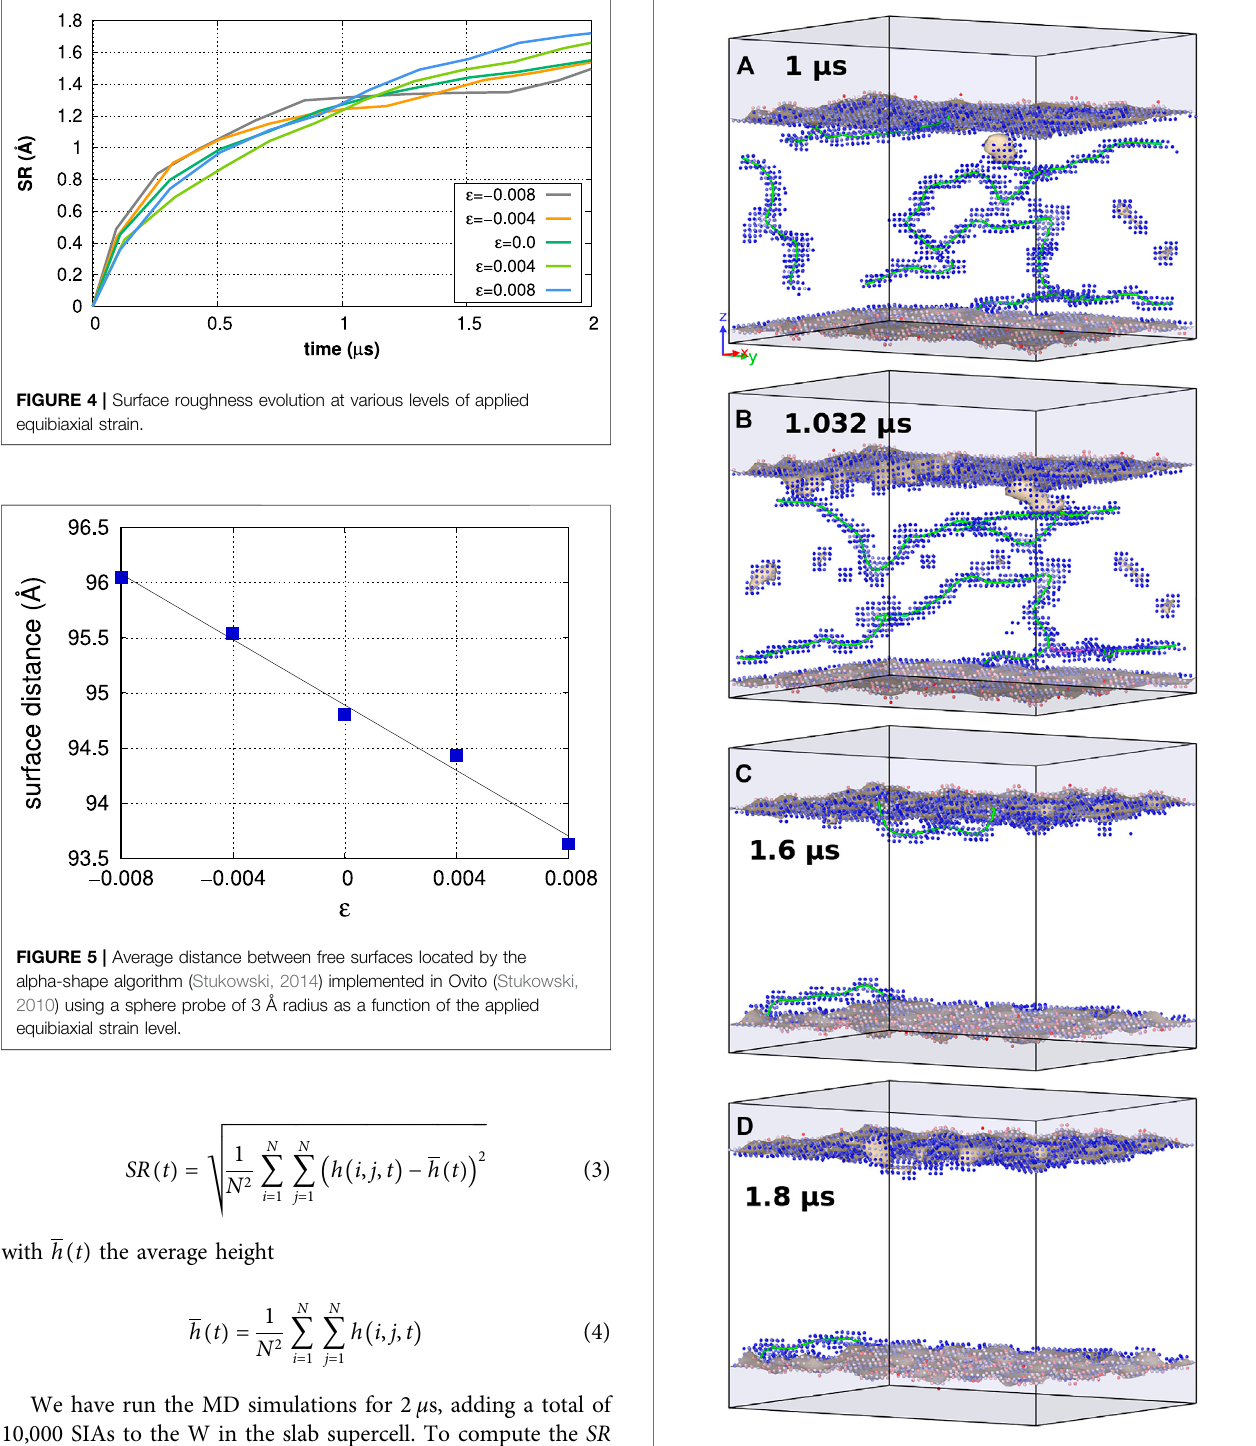
FIGURE 6 | Evolution at different simulated times denoted in each sub fi gure,ofaWslabwith ( 110 ) surfacesunderequibiaxialtensilestrain ε 11 (cid:2) ε (cid:2) 0 . 008showingthepresenceofedgedislocations(greenlines)generated 22 as aggregates of SIAs and annihilating at the surface, forming grooves that dissolve due to diffusive